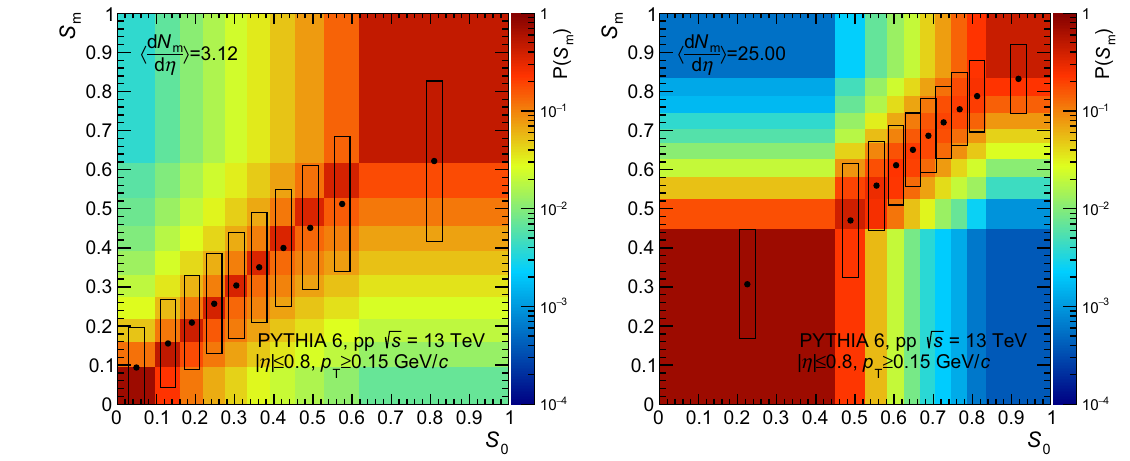
the average (RMS) of the measured spherocity distributions for each bin of spherocity at generator level. The spherocity binning varies with d N m / d η , because in this way, it allows the analysis of ten event sub- classes of equal size. The probability that an event with spherocity S 0 be reconstructed with spherocity S m is represented by P ( S m